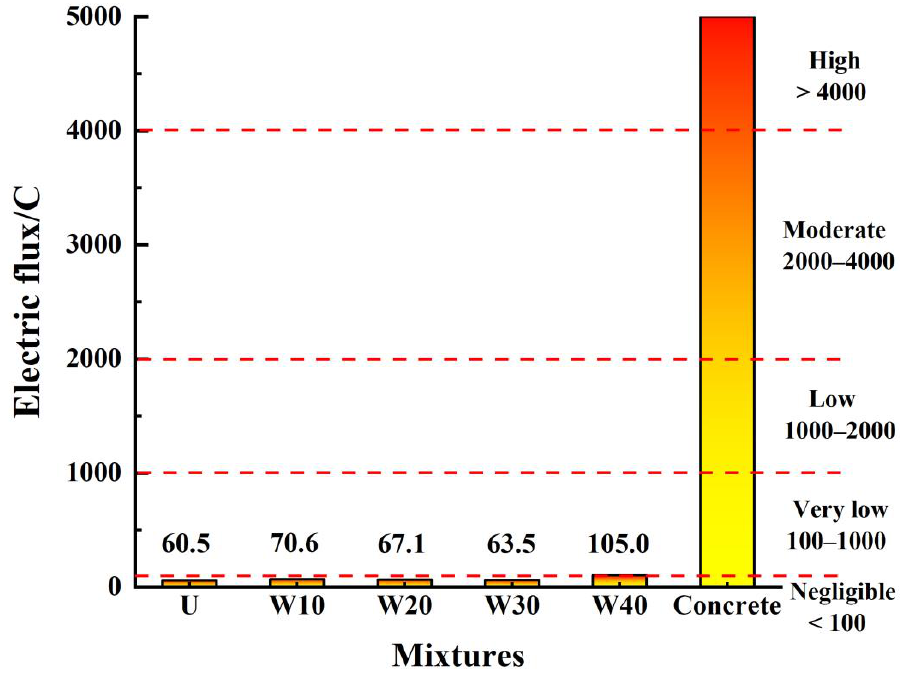
Figure 8. Effects of lead – zinc tailings content on the conductivity of UHPC [106].